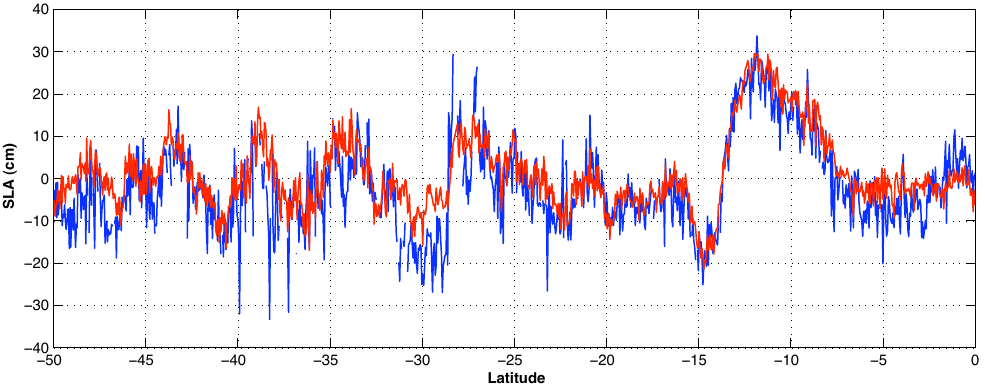
Fig. 5. Filtered SSH for pass 143 of cycle Jason-1 cycle 300 using the Gower (2007) techniue (blue) and the Ablain et al. (2006) technique (red).